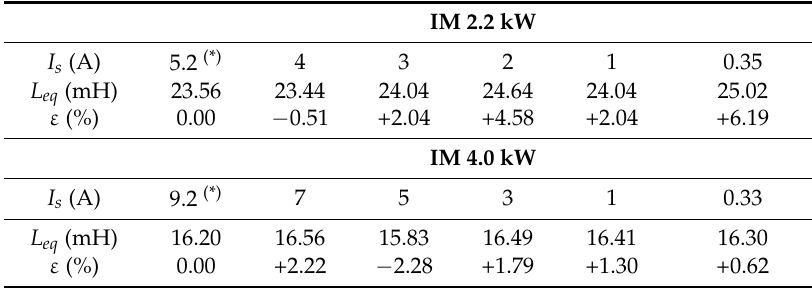
Table 3. Variance of equivalent inductance at reduced stator currents.